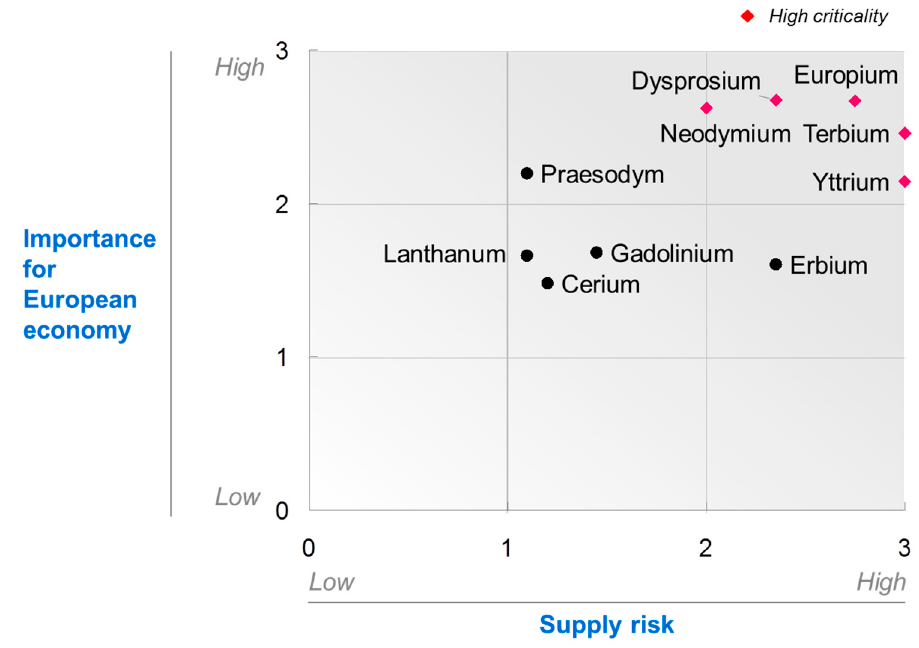
Figure 2. Criticality matrix [37].